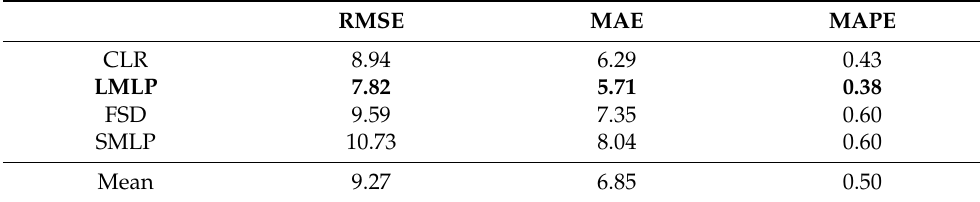
Table 5. Three-year forecasting performance obtained by various single models. RMSE